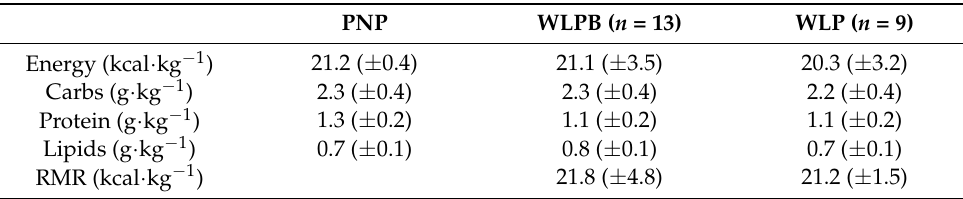
Table 2. Calorie and nutrient intake calculated from self-reported food intake.